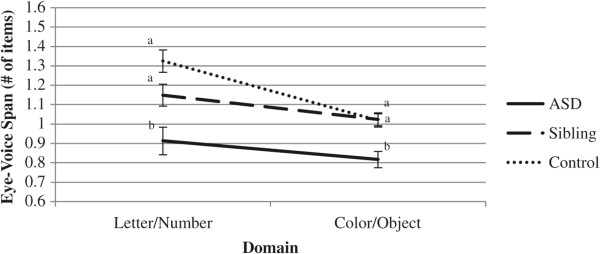
Line graph of domain by group interaction for eye-voice span (EVS). Groups with different subscripts differ at p < .05.